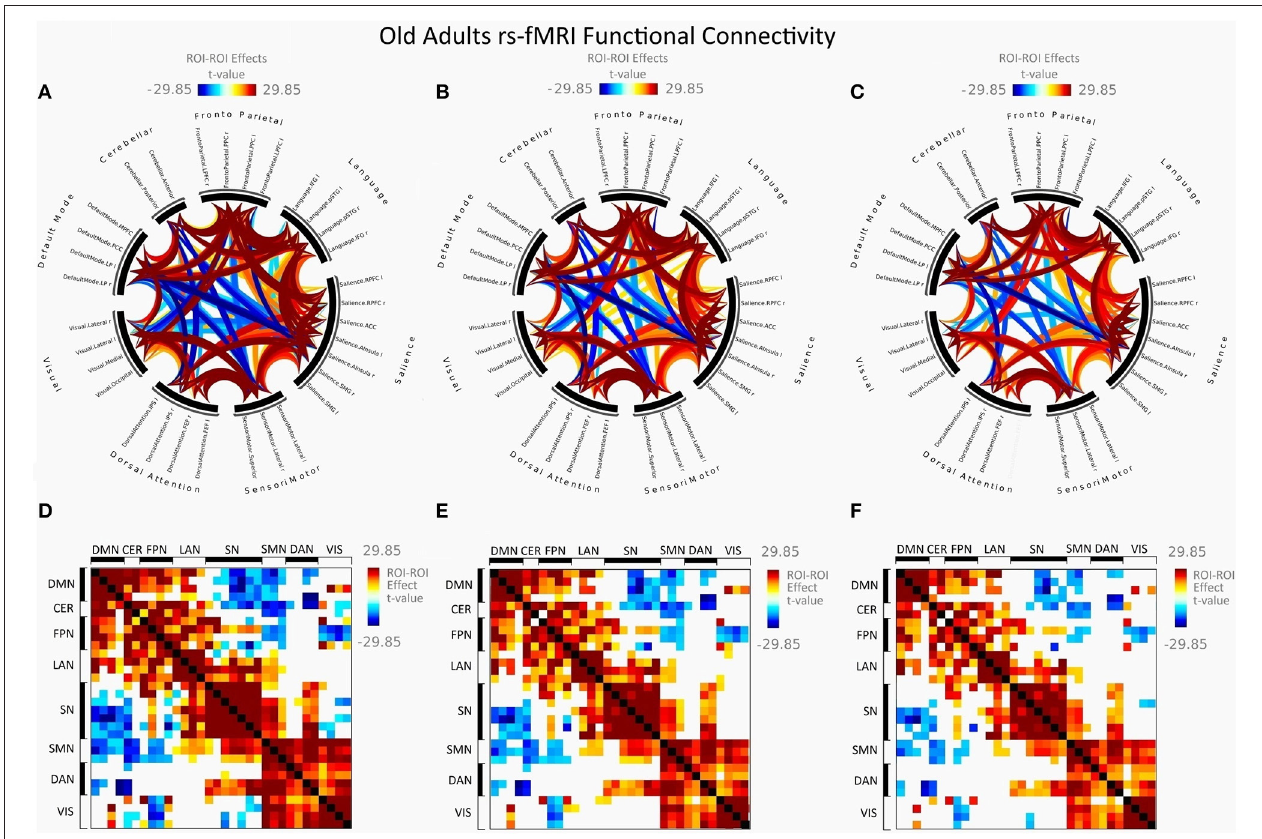
FIGURE 3 | Mean FC in female elderly adults presented as a connectome ring and a connectivity matrix showing nodes with increased FC (red) and decreased FC (blue). Connectome ring network correlations computed using: (A) Functional network connectivity (FNC). (B) Spatial pairwise clustering (SPC). (C) Network-based statistics (NBS). Connectome matrix network correlations computed using: (D) Functional network connectivity (FNC). (E) Spatial pairwise clustering (SPC). (F) Network-based statistics